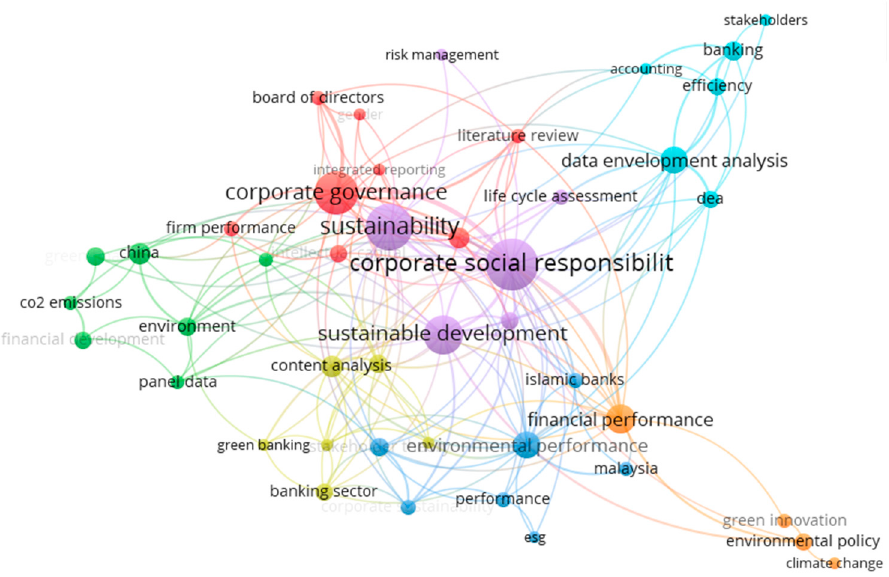
Figure 1. Co-citation analysis of authors’ keywords. Source: Scopus/Biblioshiny.